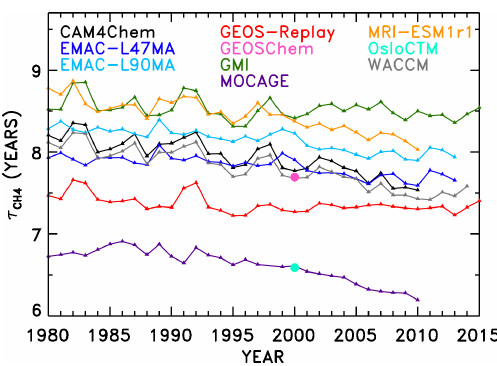
Figure 6. Time series of CH 4 lifetime from REF-C1SD models. Only 1 year of output was available for two models (OsloCTM and GEOS-Chem), so their results are shown only as a single data point for the year